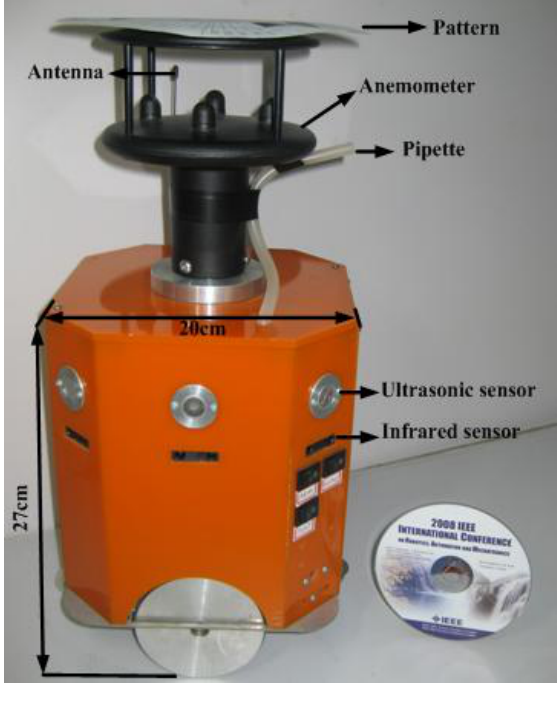
Figure 8. The small mobile MrCollie robot and onboard